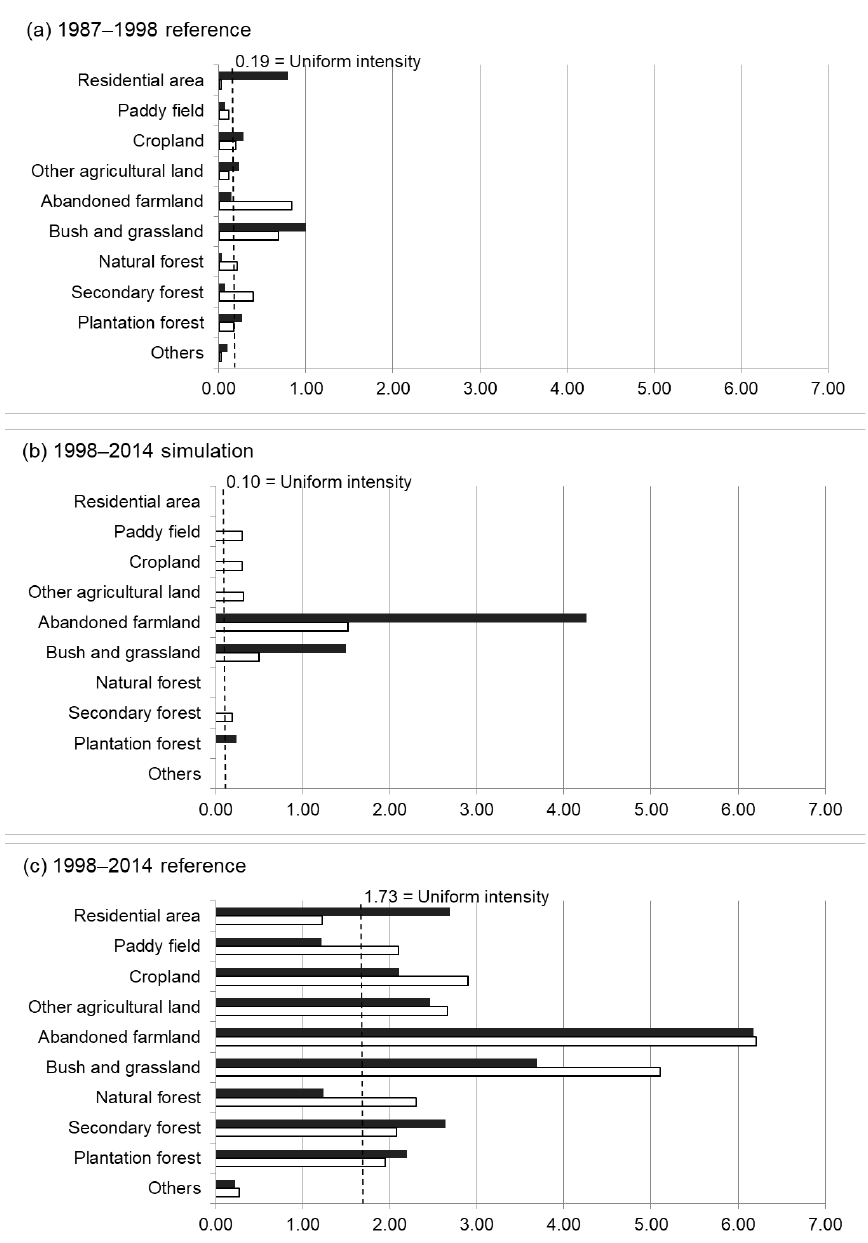
Figure 2. Category intensities for the ( a ) 1987–1998 reference (calibration), ( b ) 1998–2014 simulation, and ( c ) 1998–2014 reference (validation) intervals. Black bars show the gain intensity and white bars show the loss intensity. The vertical dashed line shows uniform intensity.